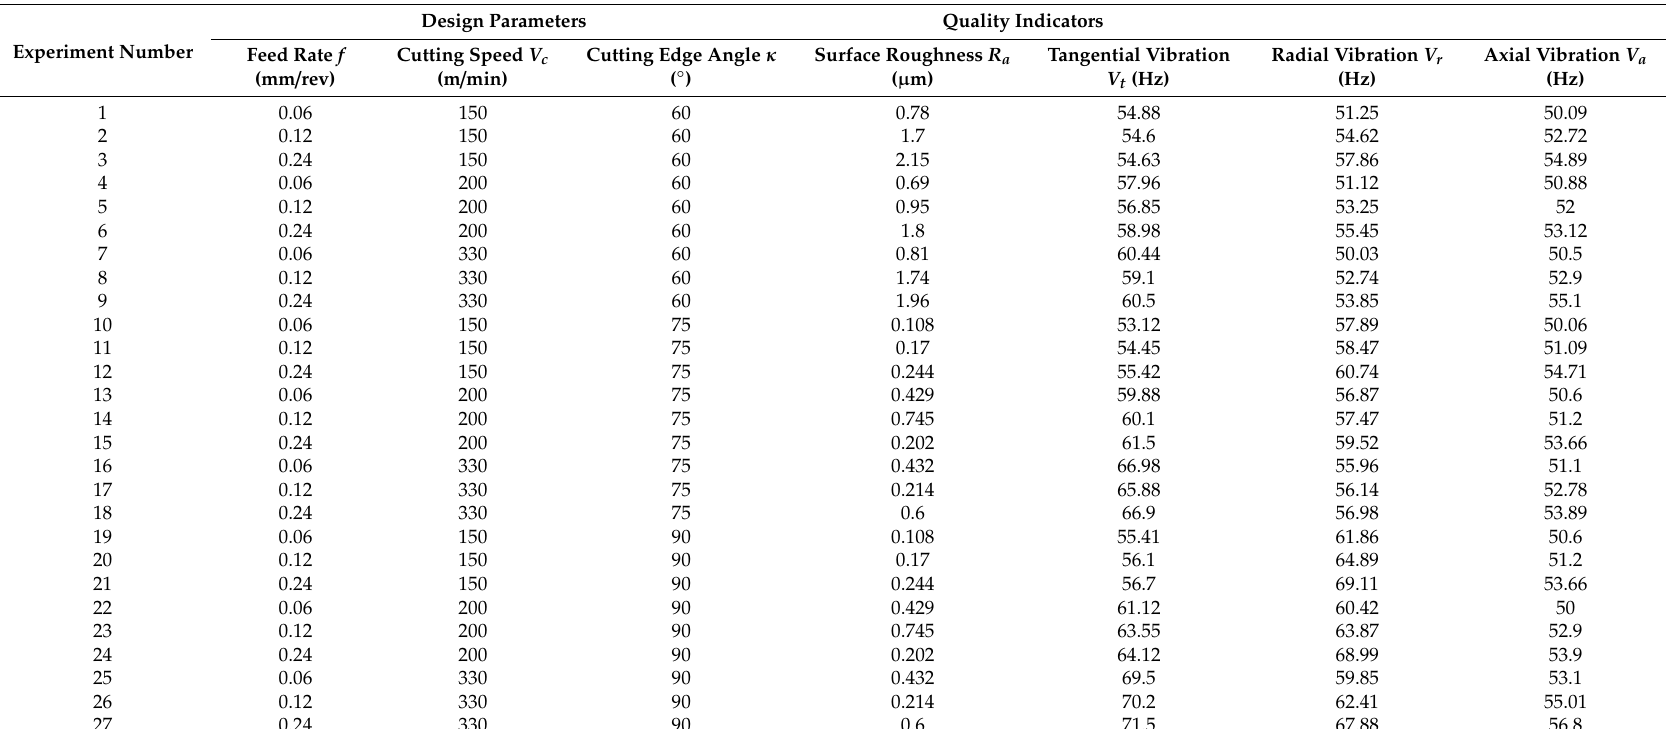
Table 4. The experimental design and